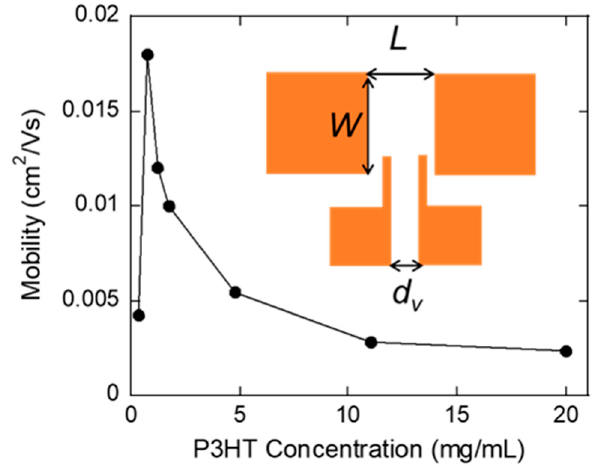
Figure 5. Plot of P3HT four-point mobility as a function of P3HT concentration of sonicated P3HT solution. The inset shows a four-point geometry gated-device (L = 200 µm, W = 2800 µm d v = 80 µm, and V diff = V 1 − V 2 ).